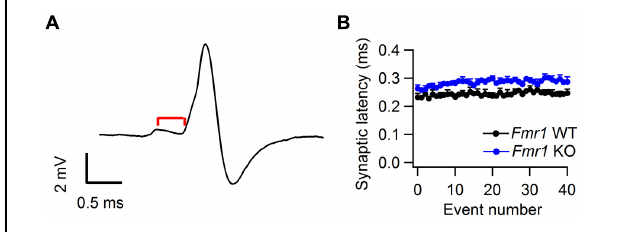
FIGURE 6 | Synaptic latency in Fmr1 WT and KO mice. (A) Representative complex waveform from a Fmr1 WT neuron. Red line indicates the latency between prespike and EPSP onset (B) Relation between average synaptic latency and sound-evoked event number. Data is from both Fmr1 WT (black) and Fmr1 KO animals. Error bars indicate the SEM of the different averages.